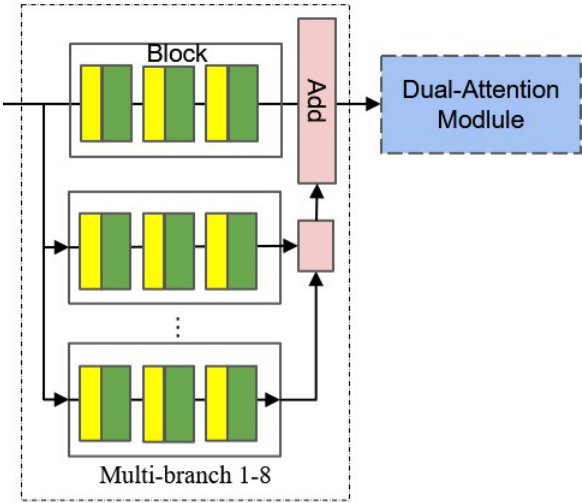
Figure 5. Schematic for the connection between the attention module and a multi-branch block.